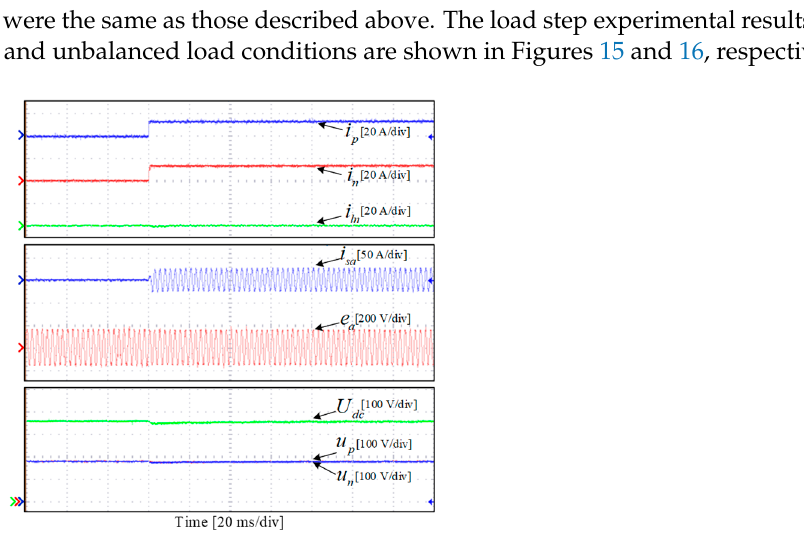
waveforms of TCIBAR and ( b ) fast Fourier transform (FFT) results of the phase current.